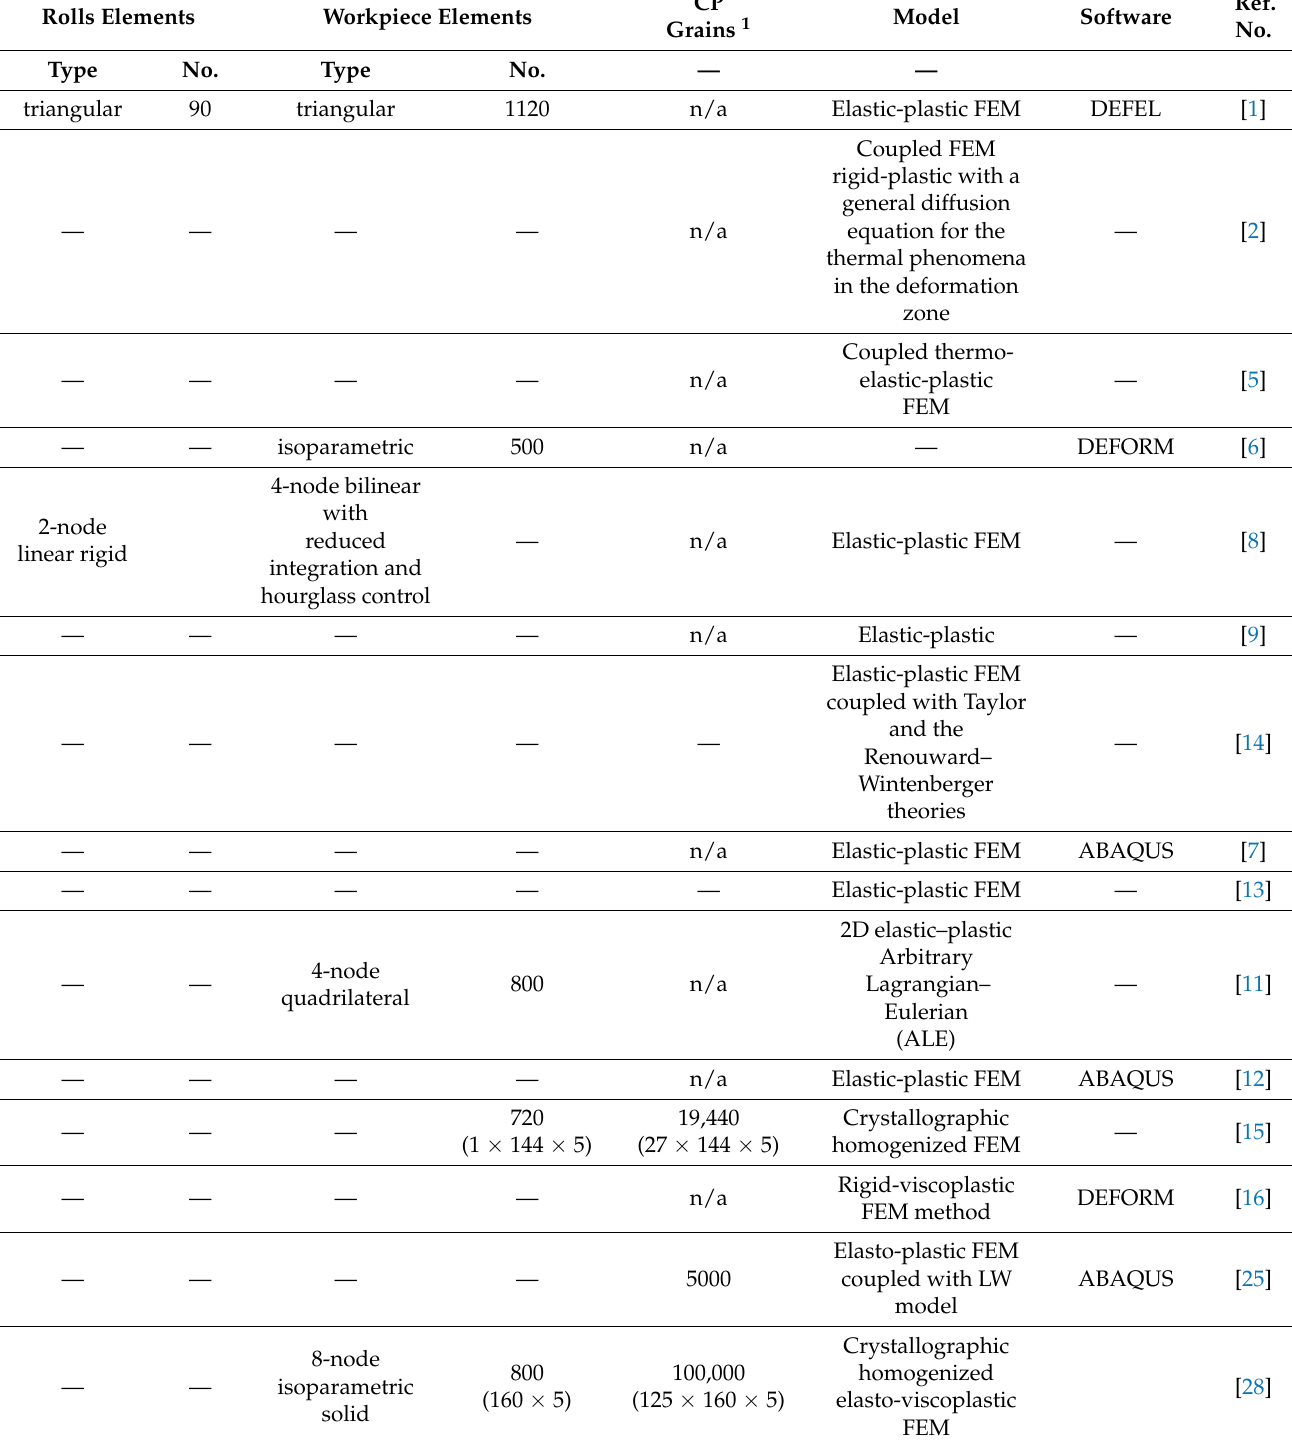
crystallographic analysis, where the problem is discretized at the crystal level, Table 4 also indicates the number of grains selected. Next, the FE models that include crystallographic approaches are briefly described. Table 4. FEM models, mesh parameters, and commercial software used in ASR simulations by different authors. Ref. Model Software Rolls Elements Workpiece Elements Grains 1